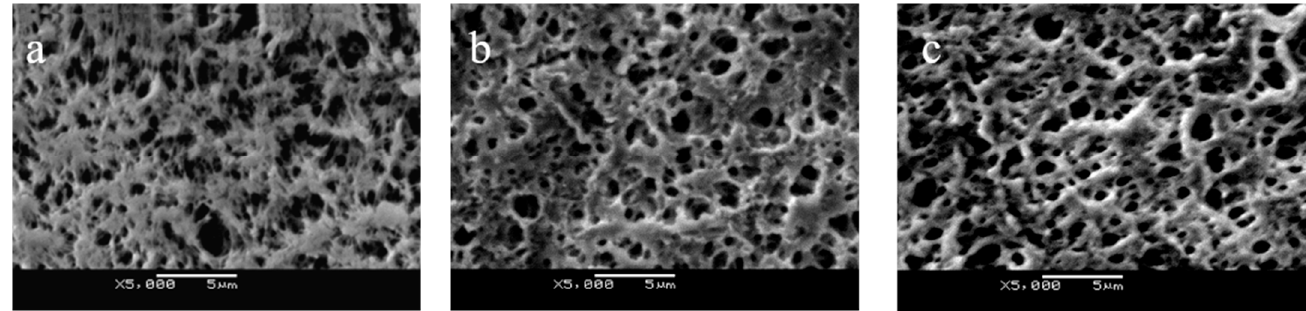
Figure 2. The SEM images of ( a ) PP membrane, ( b ) PP-pDA membrane, and ( c ) PP- g -pDMAEMA membrane.